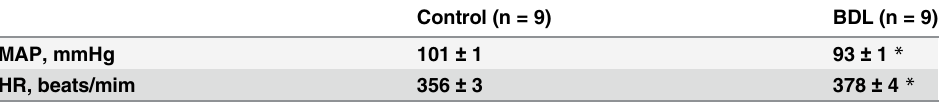
Table 2. Summary of data on cardiovascular parameters in the different experimental